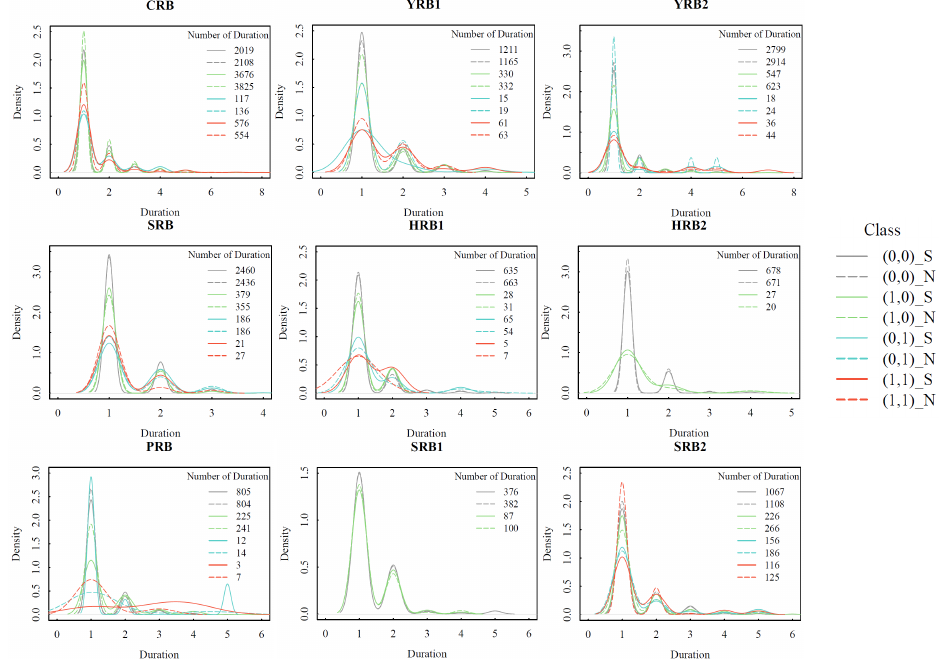
Figure 6. Probability density of duration estimated by SPEI and NSPEI in the nine river basins of China under different classifications of ( μ , σ ) changes in the spring–summer season.